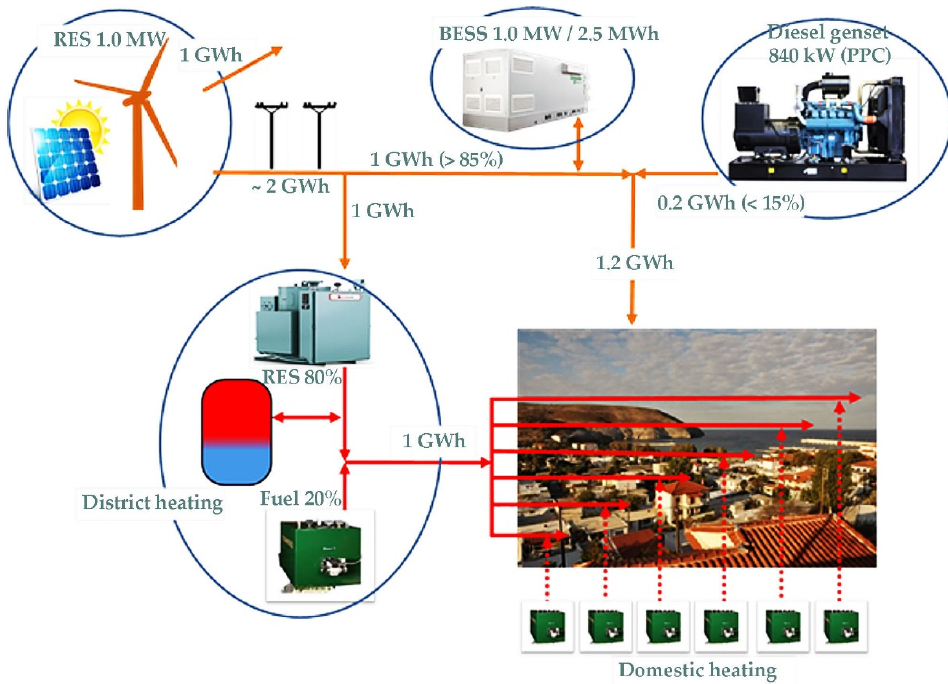
Figure 12. The layout of the overall energy transition project in Agios Efstratios.